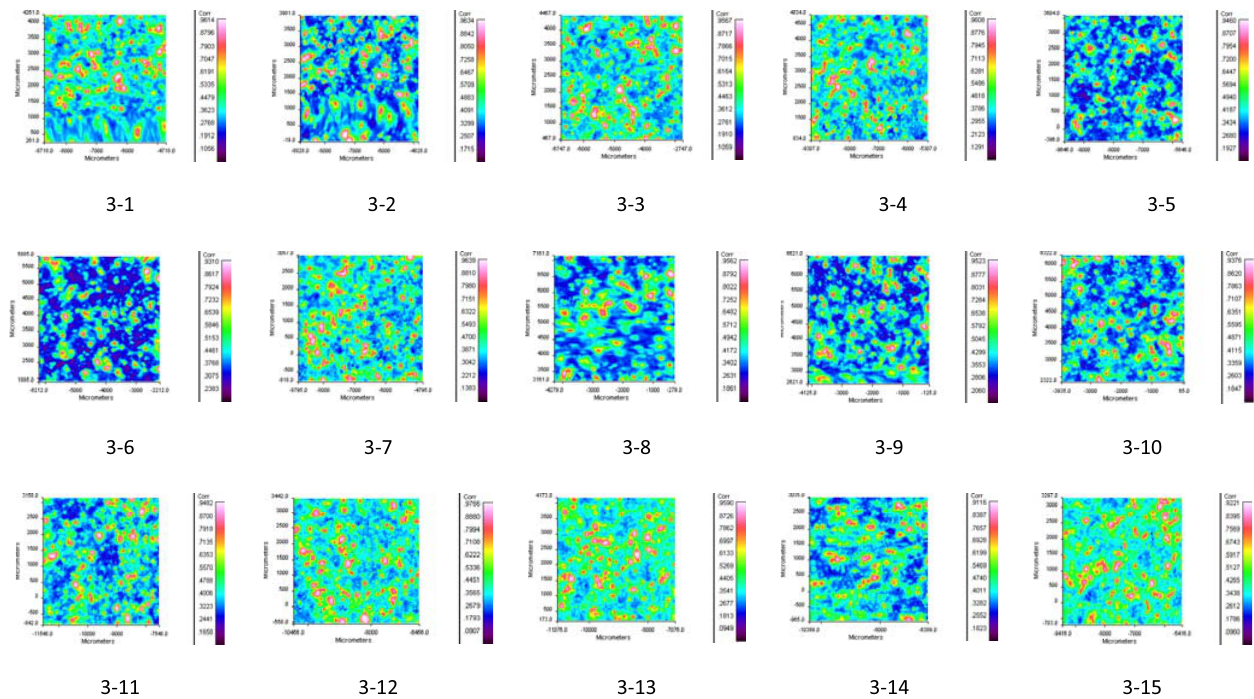
Fig. 3. BACRA analysis of PVPP with Radix S. Baicalensis extract, magnesium stearate image in Yinhuang dispersible